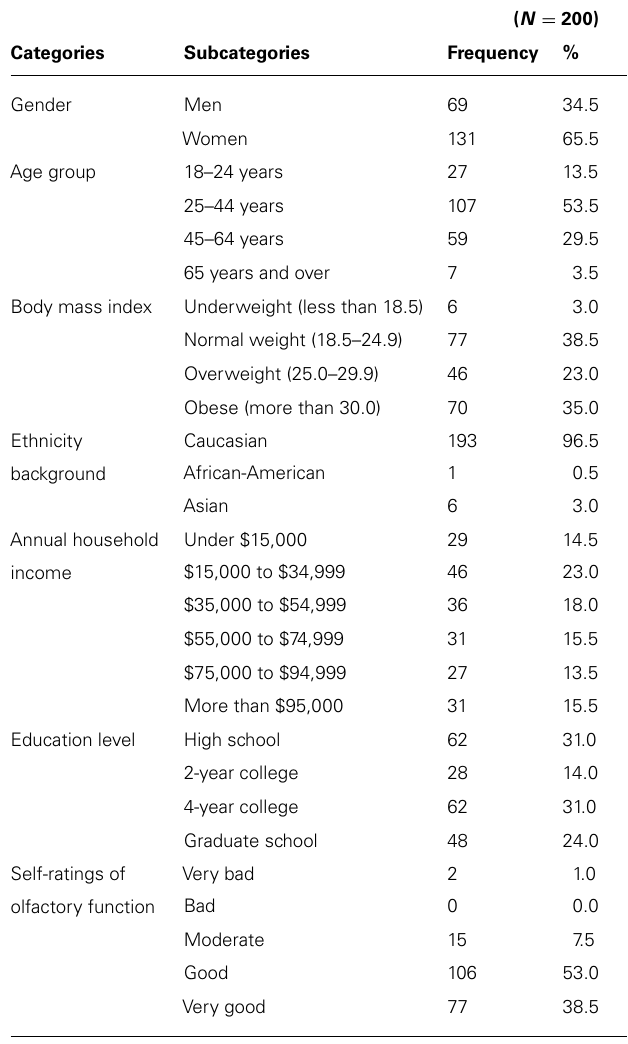
Table 1 | Participants’ demographic profiles and self-ratings of olfactory